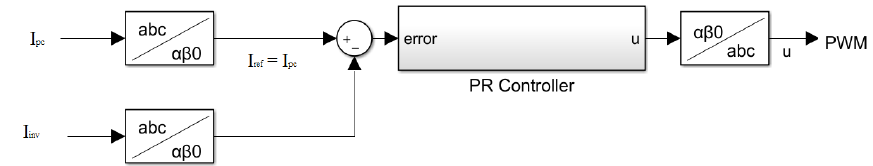
Figure 2. Current control using PR controller.